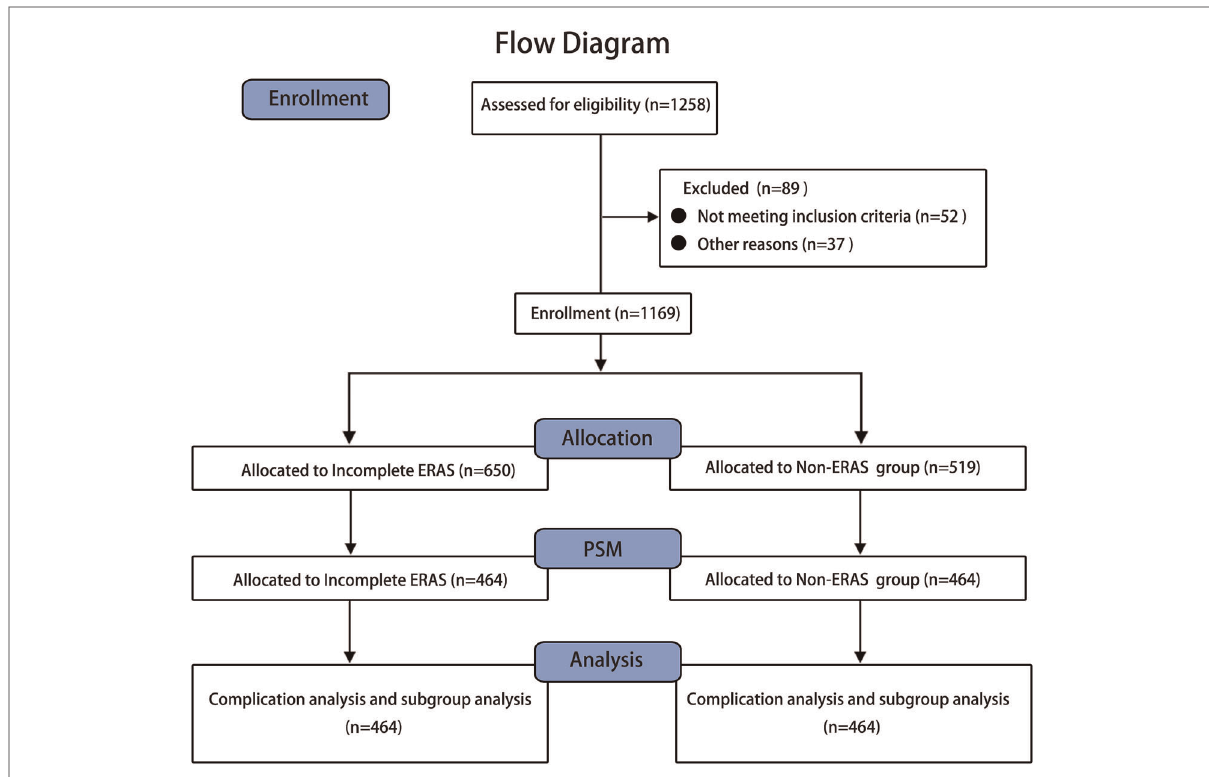
FIGURE 1 Flow diagram the clinical data of 1,258 patients undergoing laparoscopic radical colorectomy at four large university hospitals between August 2008 and December 2020 were collected for this study, and 1,169 were screened for study inclusion. Of these patients, 650 were assigned to the incomplete ERAS group, and 519 were assigned to the non-ERAS group. After PSM (propensity score matching), 464 pairs of well-matched patients were generated for